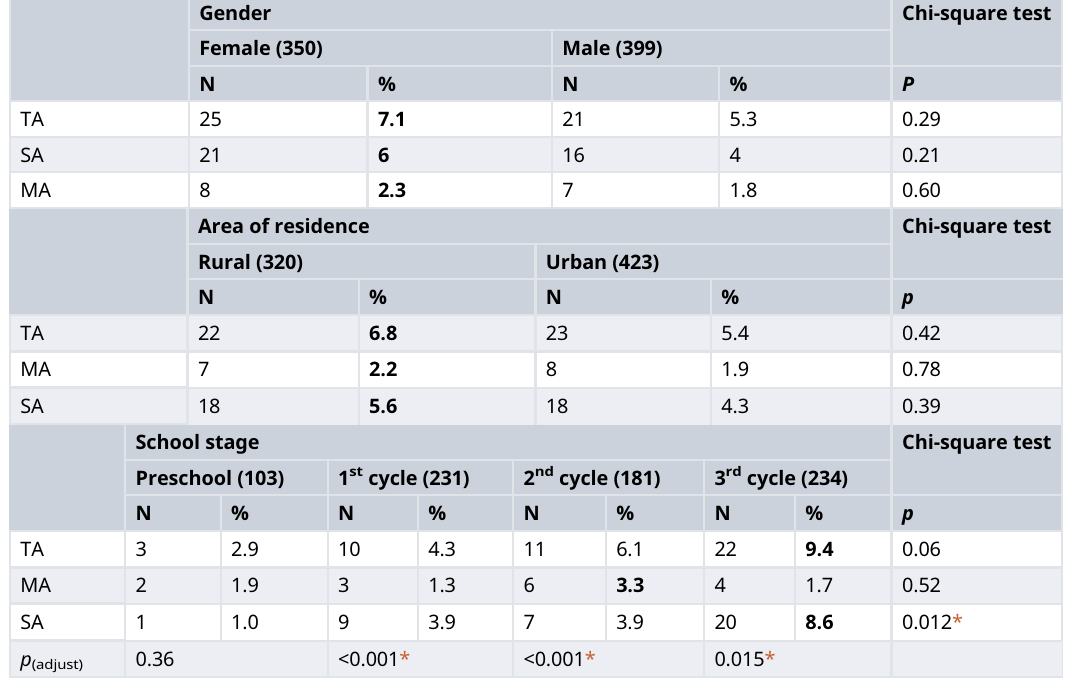
Table 4. Relationship of gender, area of residence and study cycle, in anisometropia. Gender Chi-square test Female (350) Male (399)